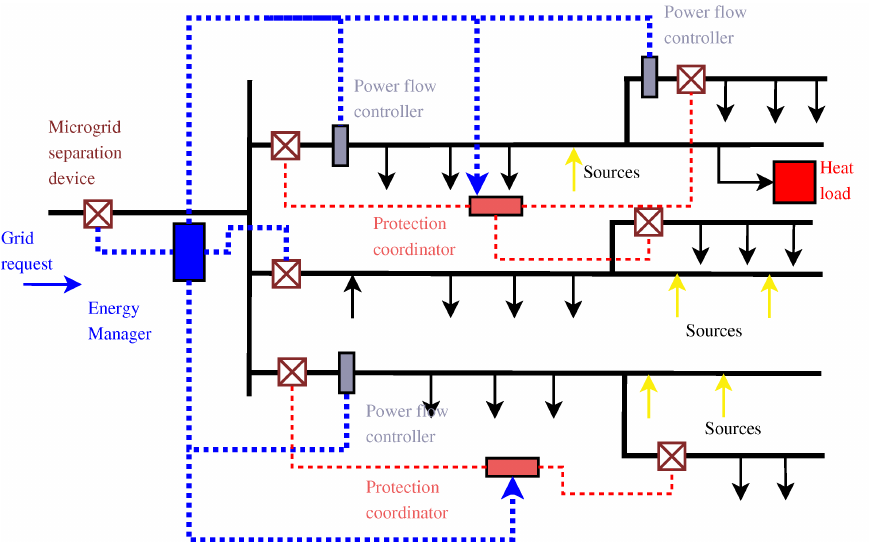
Figure 20. Example of a